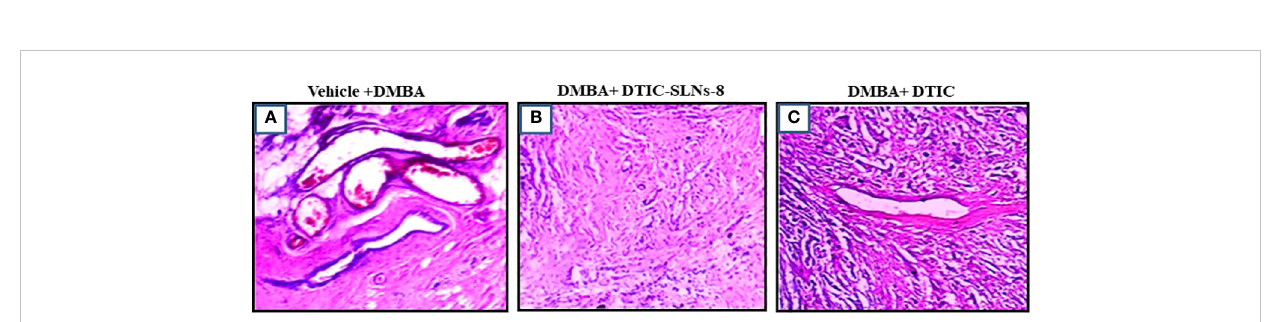
FIGURE 8 Histology (hematoxylin-eosin (H&E) staining) of the skin of hairless rats after treatment with DMBA+ DTIC-SLNs-8 and DMBA+ DTIC (0.01%w/v). (A) (0.01%w/v) Group; (B) DMBA+ DTIC-SLNs-8 Group; (C) DMBA+ DTIC Group. Each specimen was subjected to H&E staining and photographed at a magni fi cation of 400x. Scale bar = 100 µm. (A) Arrow represents Squamous cell carcinomas with large nuclei and high mitotic fi gure & in fl ammation: H&E x400. (B) Squamous cell carcinomas with very minure nuclei and minure mitotic fi gure. (C) Squamous cell carcinomas with moderate nuclei and moderate mitotic fi gure H&E x400.